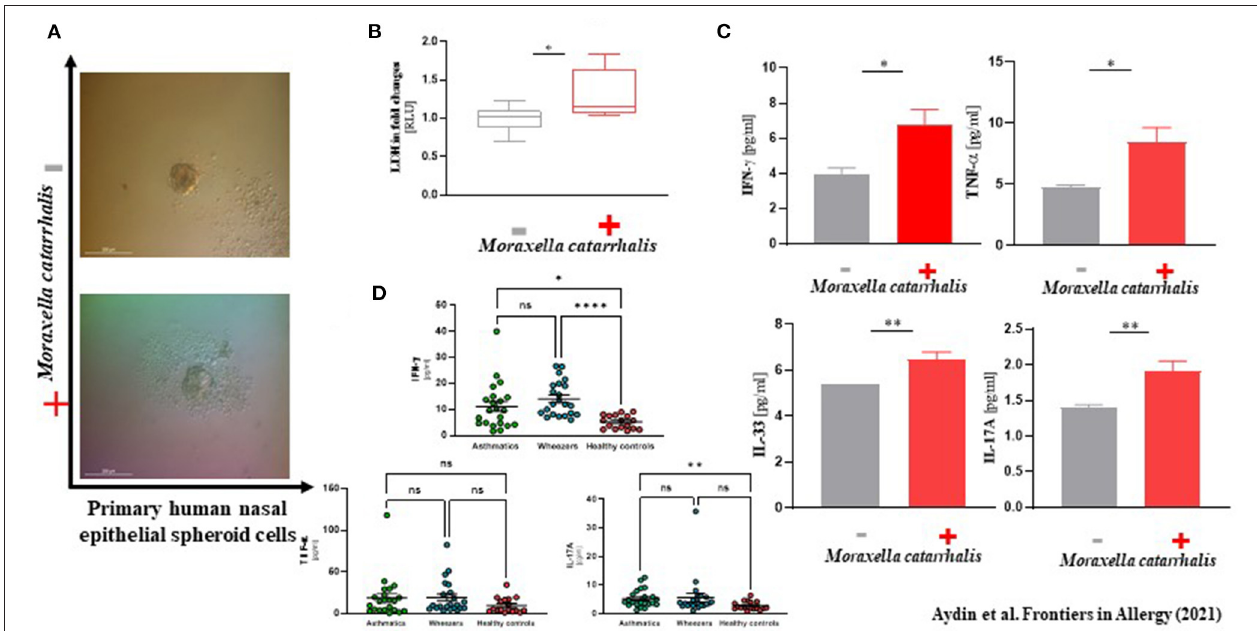
FIGURE 3 | Phenotype-specific Moraxella catarrhalis infection could be associated with a disruption of epithelial integrity in vitro . (A) Primary human nasal epithelial cells were used for spheroid (NAEsp) cell culture technique (1 × 10 3 cells per well). After circa 1 week, NAEsp reached a size of 200–300nm and were used for infection experiments with M. catarrhalis strains derived from AB and WH in a concentration of 5 × 10 5 cfu per NAEsp. After 24h of infection, the epithelial barrier of the spheroids was microscopically impaired. (B) Lactate dehydrogenase (LDH), as a potential epithelial damage factor, was increased in supernatants of provoked and non-provoked NAEsp with M. catarrhalis (normalized values presented as fold changes). (C) The concentration of IL-33, IFN- γ , TNF- α , and IL-17A was significantly elevated in supernatants of the exposure group with M. catarrhalis ( the non-provoked cells showed values under the detection and the measurable reference values were used for analyses ). (D) Furthermore, we then analyzed IFN- γ , TNF- α , and IL-17A in plasma samples of the study population using LEGENDplex TM bead assay. Concordantly, our pediatric exacerbation study cohort revealed a significant difference between exacerbated AB, WH, and HC, specifically for IFN- γ and IL-17A (AB, Asthmatics, n = 22; WH, Wheezers, n = 22; HC, Healthy controls, n = 17). * p < 0.05, ** p < 0.01, *** p < 0.001, **** p <